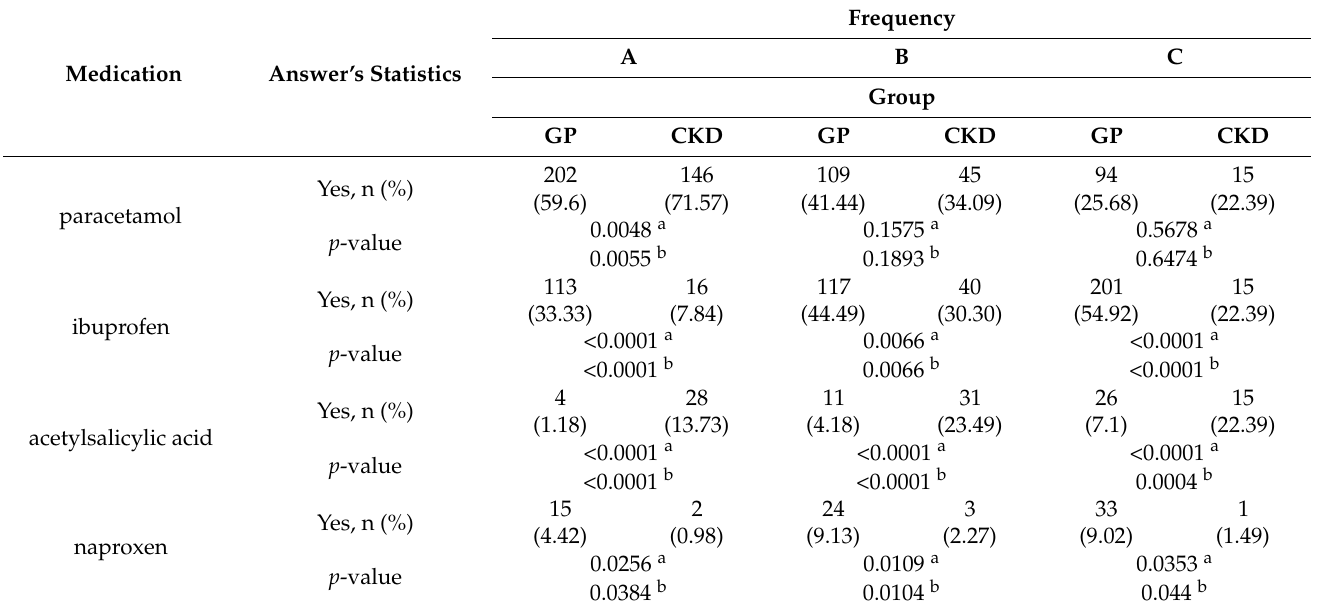
Table 5. Statistical evaluation of the most frequently used NSAIDs and analgesics in CKD and GP patients.